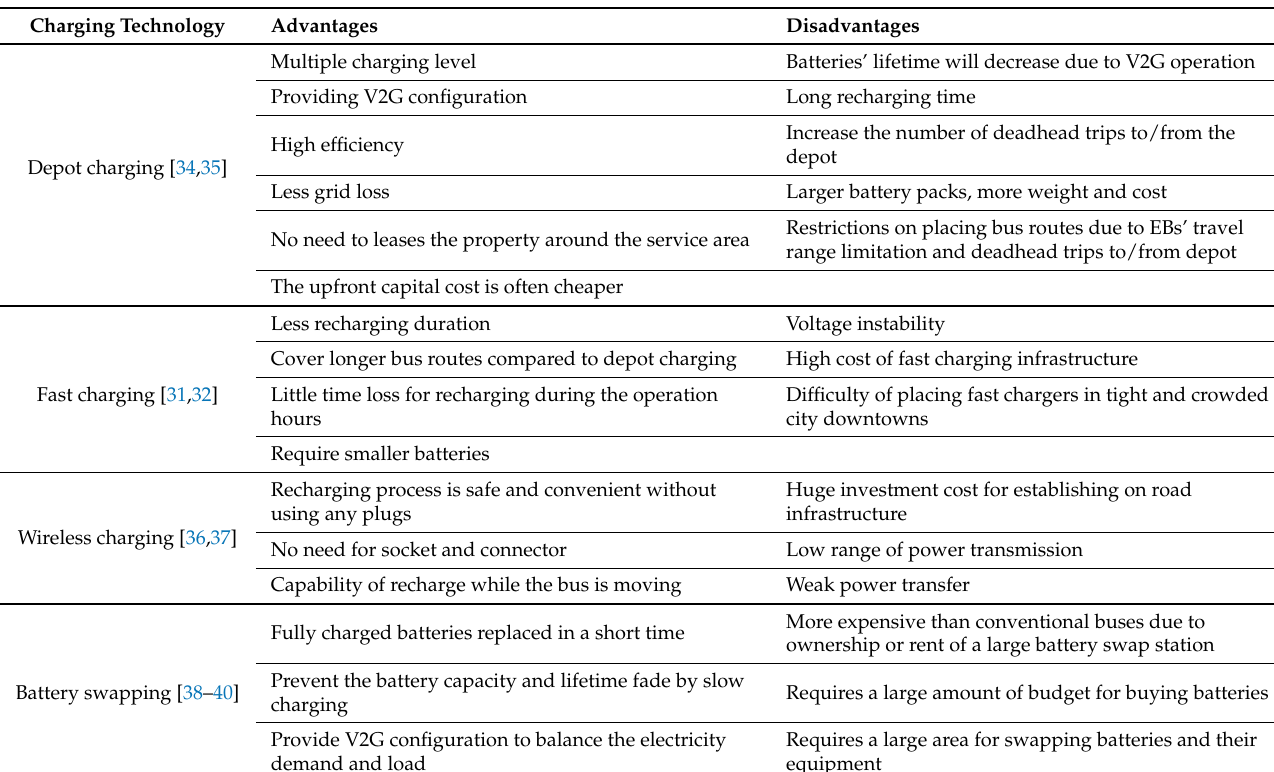
Table 4. Advantages and disadvantages of different charging